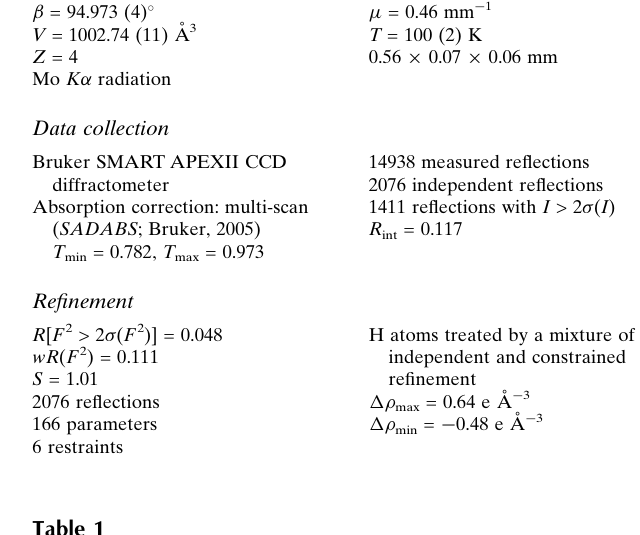
Hydrogen-bond geometry (A˚ , (cid:3)